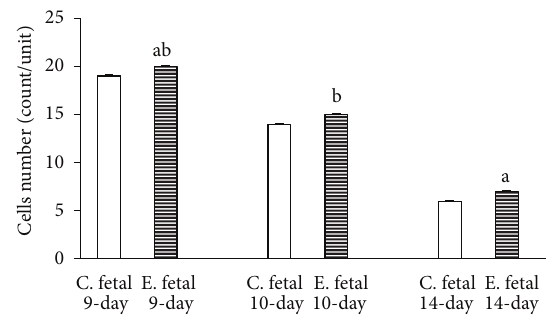
Figure 4: Reviewing the graph illustrating the time-dependent effect of oral morphine consumption on the development of the cells in the fetal portion of the placenta for three different periods of pregnancy (9-day, 10-day, and 14-day pregnant mothers), and a comparison between the experimental (E) groups and the control (C) groups reveals an increase in the number of cells in the fetal portion of the placenta in the experimental group, compared to that of the control groups ((a) 𝑃 value of < 0.01 and (b) 𝑃 value of < 0.05 indicating a significant